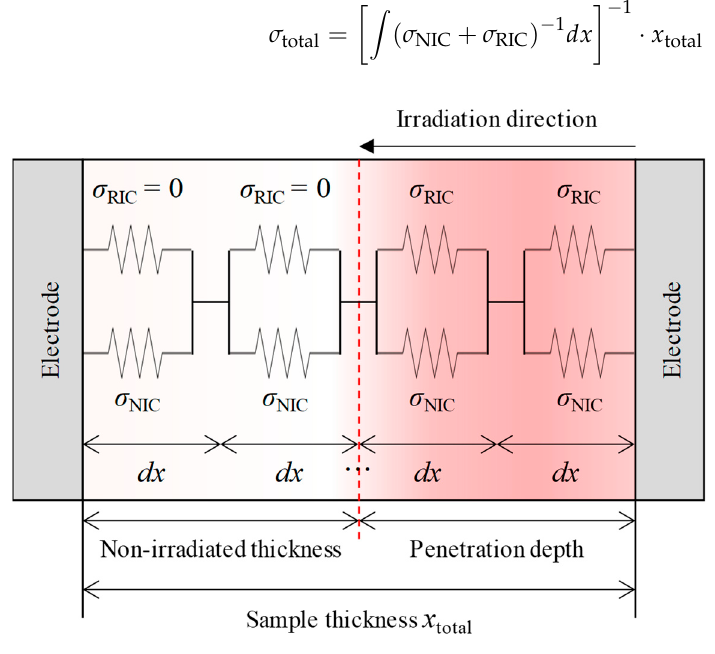
Figure 5. An equivalent circuit of the conductivity of the entire sample irradiated with proton beams.